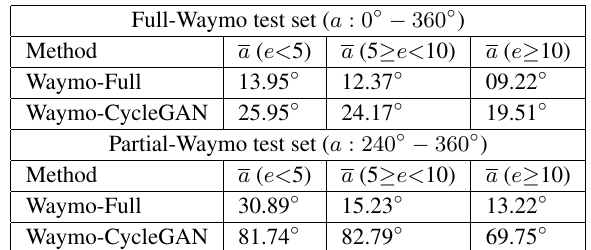
Table 2. Mean azimuth rotation accuracies of our deep convolutional neural network for the Full- and Partial-Waymo test set for different elevation angle classes